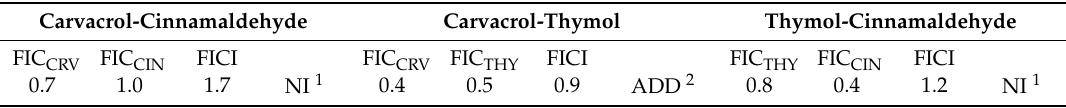
Table 2. Fractional Inhibitory Concentration (FIC) and Fractional Inhibitory Concentration Index (FICI) values for active compounds